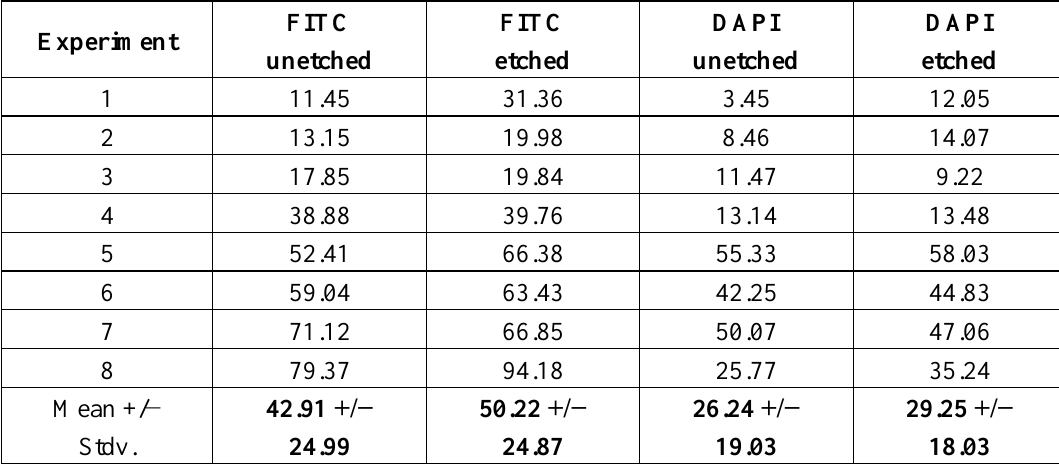
Table 1. The proportion of the platelet surface area in percent covered by cytoplasm (as indicated by FITC-labelled actin) and nuclei (as indicated by DAPI stained nuclear DNA) for unetched and etched titanium